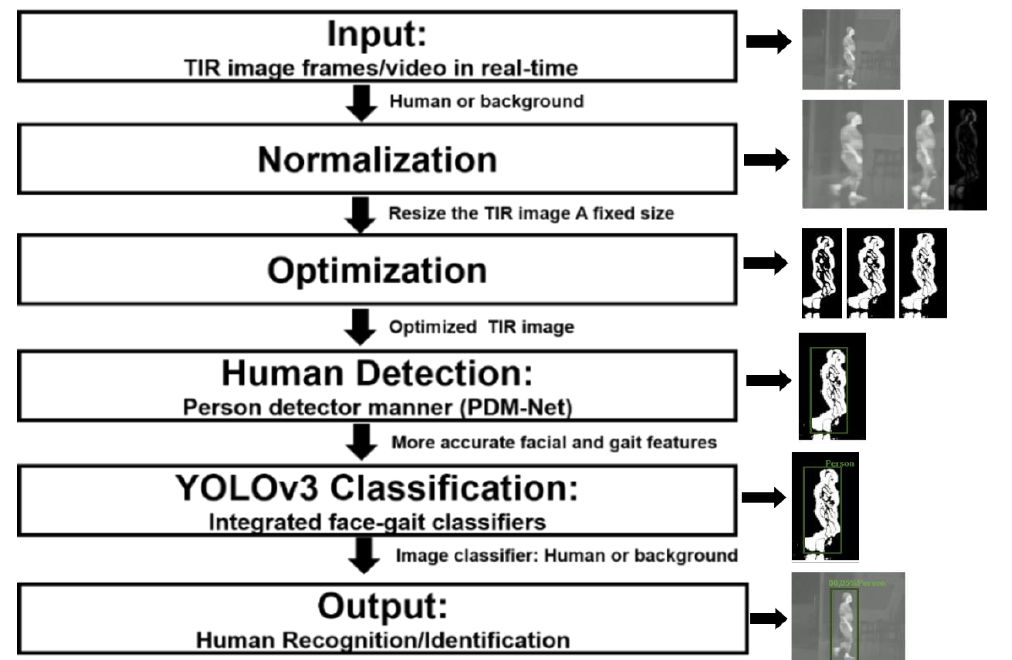
Figure 2. Flowchart of the proposed methodology procedure.